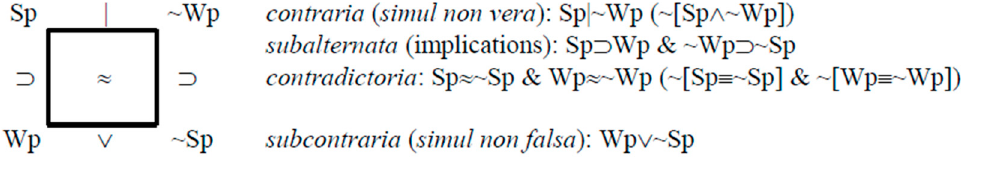
Figure 1. The Scholastic “square of opposition”.